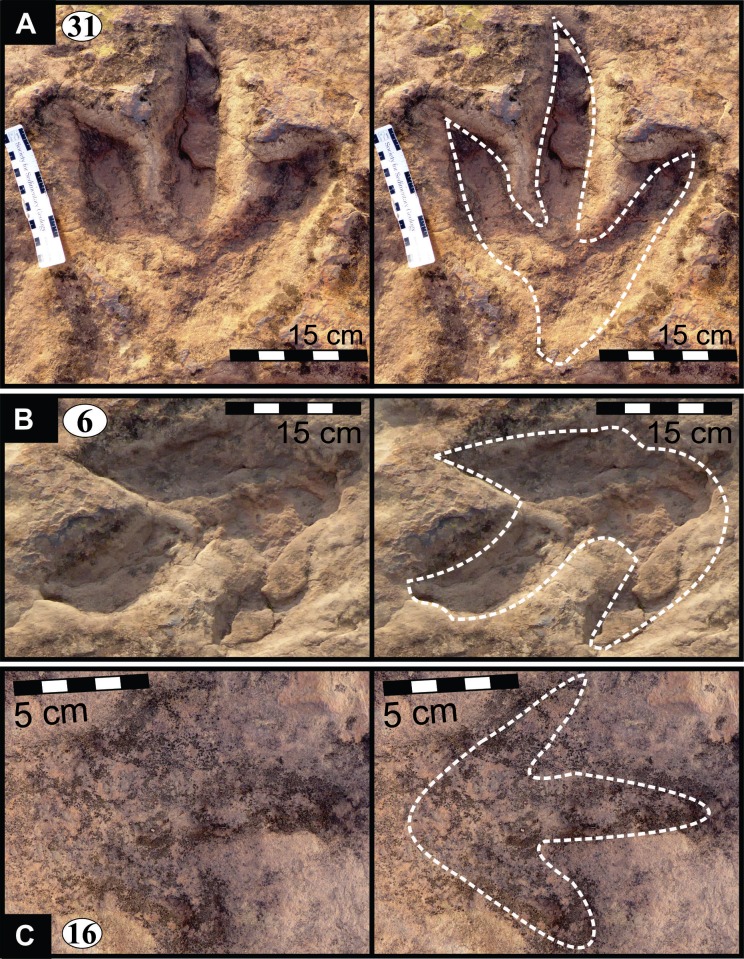
Photographs and interpretative outline tracings of individual tracks at the Mafube dinosaur track site.(A) Right pes of track #31 represents one of the largest tracks at Mafube (Fig. 5C; Table 1) with its digit II alone being 21 cm long. The digit impressions have a distinct curvature towards their V-shaped tips; digit II and IV curve divergently. Digit III retains some of its natural cast. The digit impressions are deeper than the poorly defined heel. (B) Track #6 has steep track walls and V-shaped digits with their natural cast still largely present at their tips. (C) Track #16 represent morphotype B as it is half the size of the larger tracks of morphotype A. This very shallow track shows straight digits with U-shaped tips.